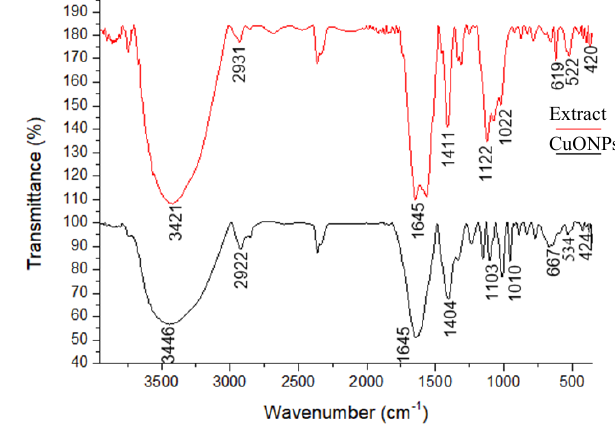
Fig. 4. Spectra of AC extract and CuONPs